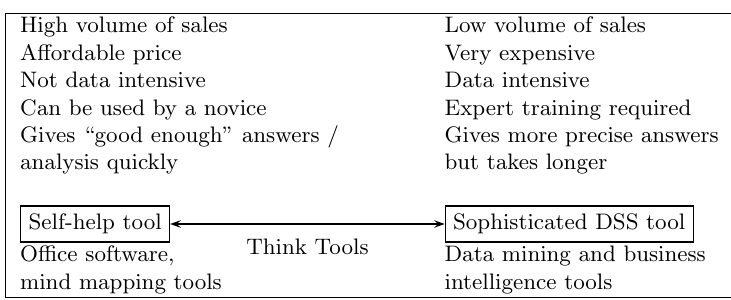
Figure 1: Comparison of self-help and sophisticated decision support